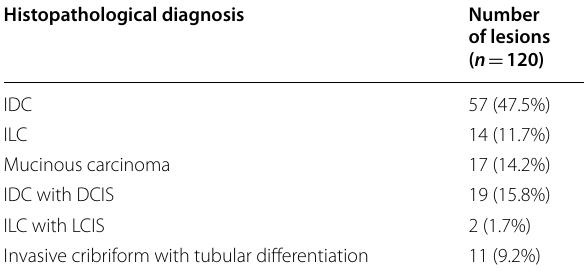
Table 1 Histopathological results of the different malignant lesions Histopathological diagnosis Number